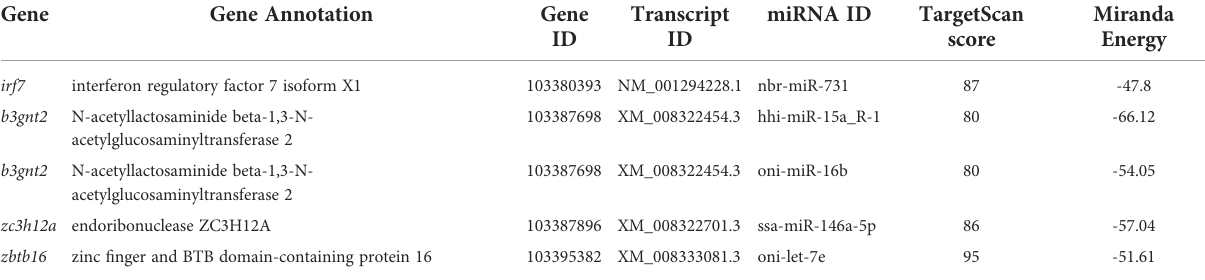
TABLE 2 Five pairs of candidate miRNAs and their target genes involved in in fl ammatory and immune responses selected by TargetScan and Miranda